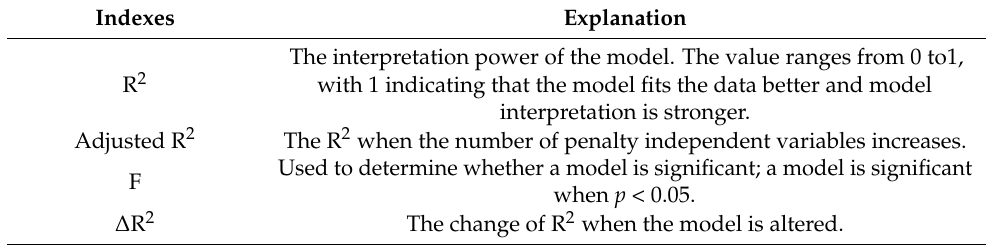
Table 2. Evaluation statistics for HMR.